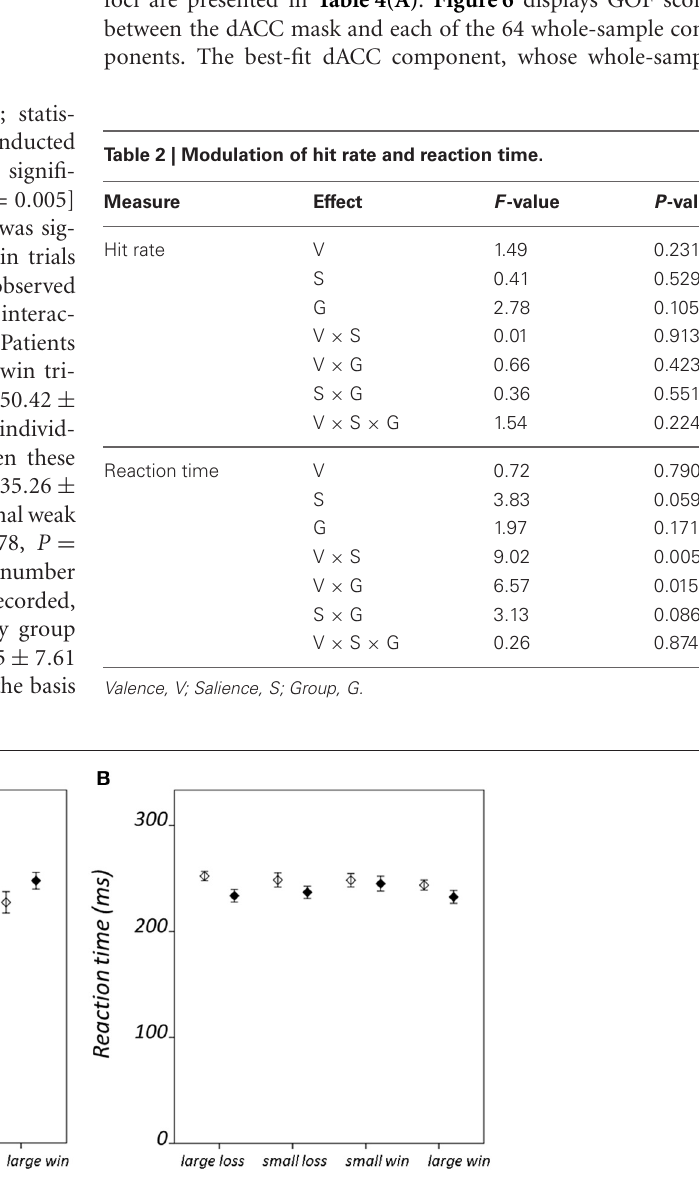
Frontiers in Human